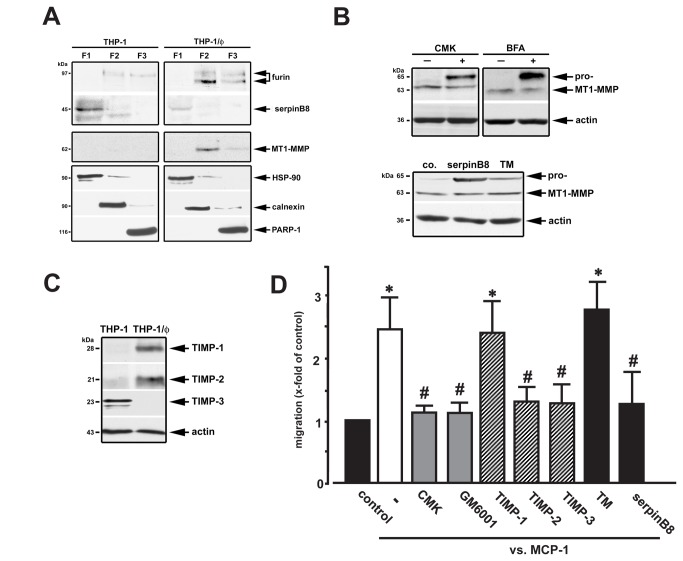
Subcellular localization and interaction of furin, MT1-MMP and serpinB8.(A) Subcellular localization of furin, serpinB8 and MT1-MMP was compared in THP-1 and THP-1/ϕ using cell fractionation. SerpinB8 was mostly found in THP-1 cells in the cytosolic fraction (F1). Furin and MT1-MMP were highly expressed in THP-1/ϕ in the organelle fraction (F2), and to a lesser extent in the membrane fraction (F3). (B) Dec-CMK (CMK, 50 µmol/L; 12h) or BFA (10 µg/mL; 30 min) inhibited pro-MT1-MMP activation in THP-1/ϕ, evident by increases in its 65 kDa pro-form (upper panel). THP-1/ϕ were transfected with serpinB8 (5 µg/mL; 12h) or treated with transfection medium (TM) alone, and further processed for immunoblotting. SerpinB8 inhibited pro-MT1-MMP activation, evident by increases in the pro-form of MT1-MMP (lower panel). (C) Monocyte (THP-1)/macrophage (THP-1/ϕ) transformation was accompanied by increases of TIMP-1 and TIMP-2, whereas TIMP-3 was downregulated (actin-reblotting for protein loading). (D) Macrophage chemotaxis towards MCP-1 (10 ng/mL) was inhibited by the furin-like PCSK inhibitor dec-CMK (CMK, 50 µmol/L), serpinB8 (5 µg/mL), and the MMP-inhibitors GM6001 (50 µmol/L), TIMP-2 and TIMP-3 (both 200 ng/mL). TIMP-1 (200 ng/mL) and transfection medium (TM) had no effect (*p<0.05 vs. controls, co.; #p<0.05 vs. MCP-1 alone). n=3.